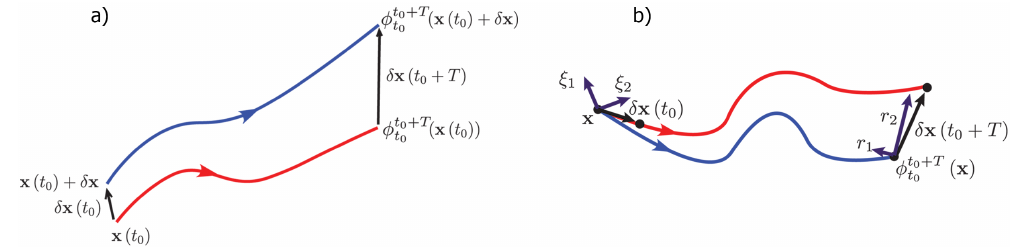
Figure 1. (a) Separation of nearby particles during time interval T due to the flow map φ . The two particles are released in the flow field at the same time t 0 ; isochronic particles. (b) ξ 2 is the direction of maximum growth at the initial point x , which evolves into the direction + T t 0 + T r 2 = Dφ t 0 t 0 ( x ) ξ 2 at the evolved point φ t 0 (x) . The closer the initial displacement vector δ x is to the ξ 2 direction, the more it will be stretched to that maximum